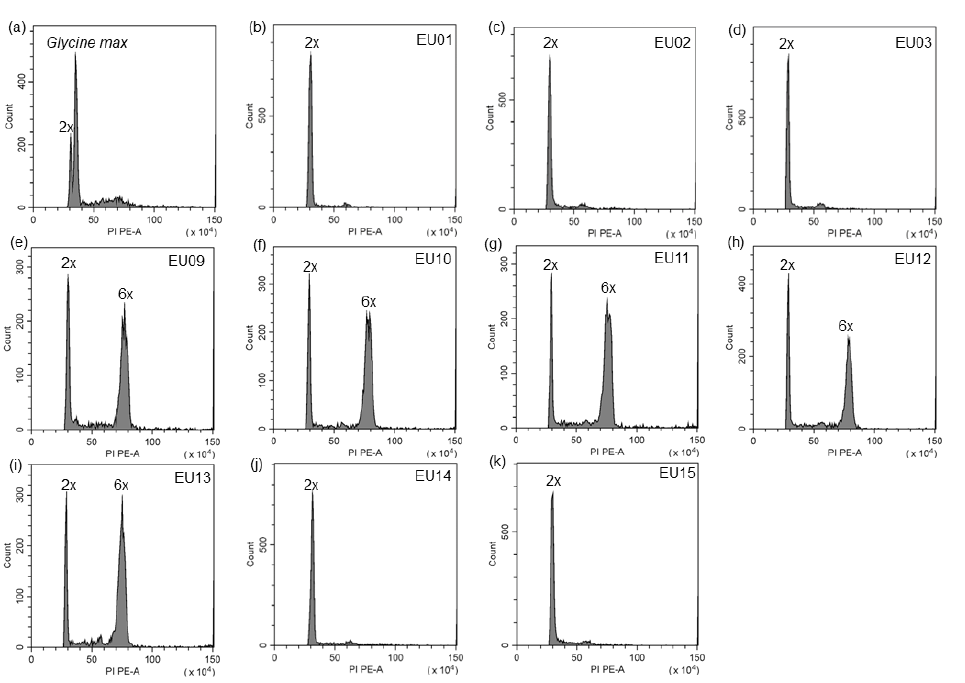
Figure 2. Flow cytometric ploidy analysis of populations in Europe. ( a ) Glycine max Merr. ‘Polanka of which DNA content is 2.5 pg [54], was used as an internal reference, therefore DNA content of the diploid population (CA09) is 2.15 pg. ( b – k ) The relative nuclear DNA content of each population, native diploid population (CA09) used as the internal